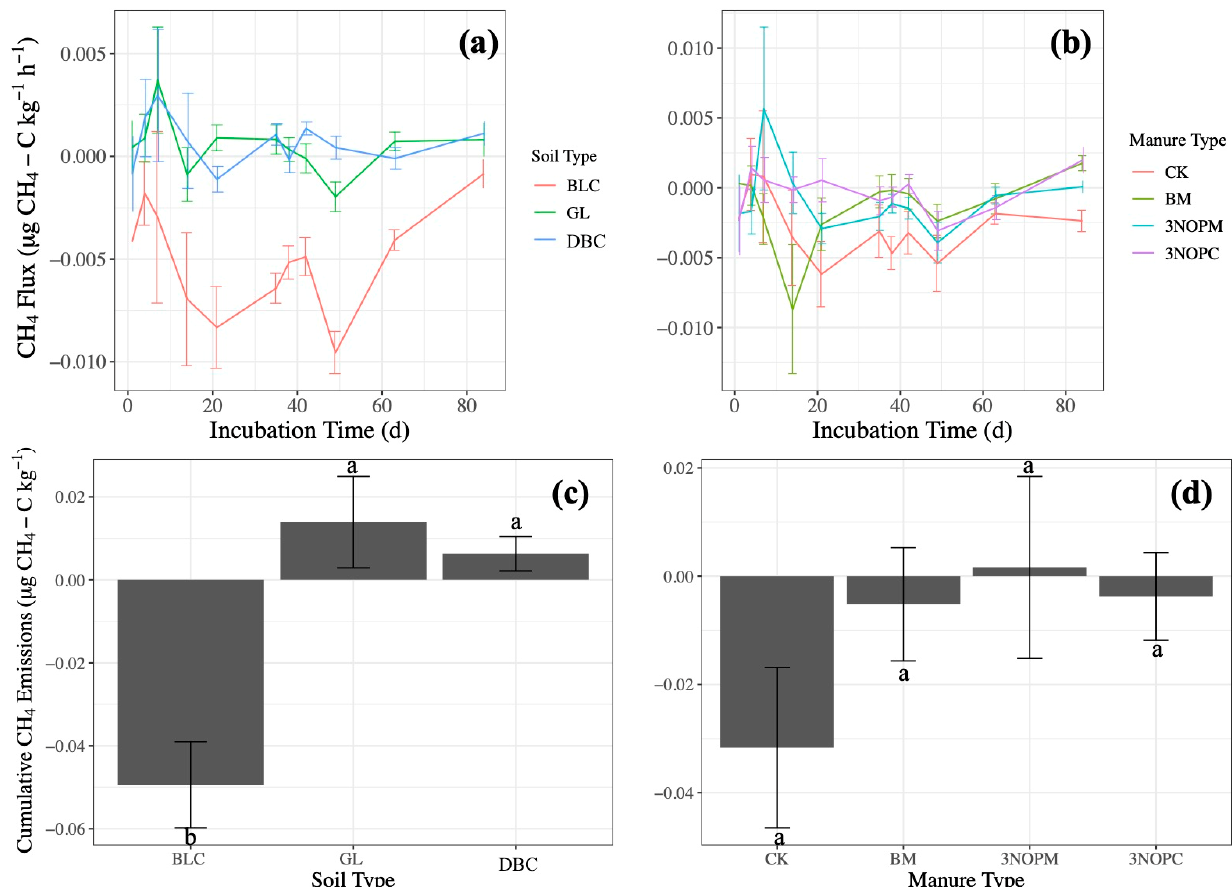
Figure 3. Effects of ( a ) soil type on CH 4 emissions over time, ( b ) manure type on CH 4 emissions over time, ( c ) soil type on cumulative CH 4 emissions, and ( d ) manure type on cumulative CH 4 emissions in a laboratory incubation experiment. Soil type: BLC, Black Chernozem; GL, Gray Luvisol; DBC, Dark Brown Chernozem. Manure type: CK, control with no amendments; BM, barley-based manure; 3-NOPM, manure from cows fed 3-NOP supplement; 3-NOPC, composted manure from cows fed 3-NOP supplements. Treatments that do not share the same letter are significantly different from each other. Error bars indicate standard errors of the means ( n = 4).